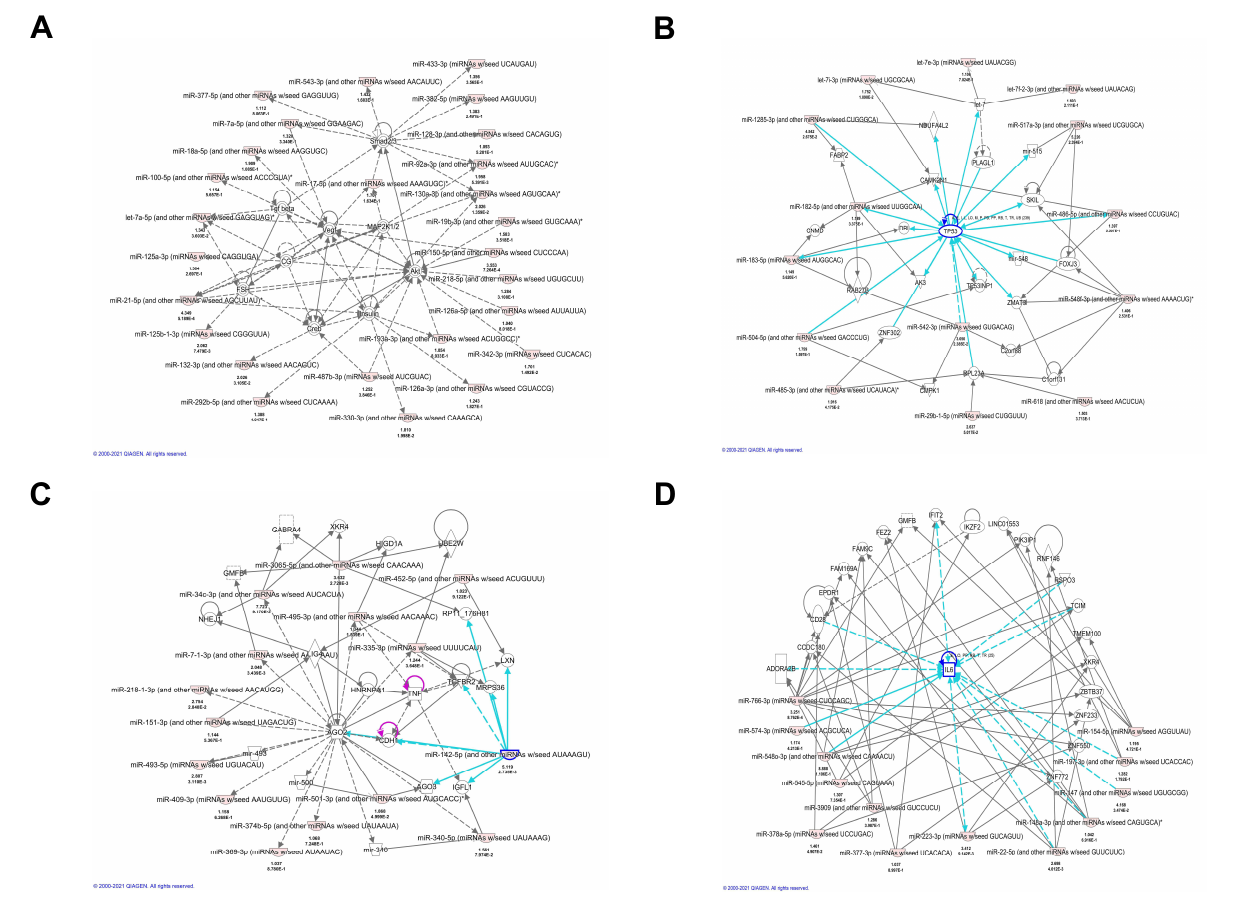
Figure 3. Top representative molecular networks involving differentially expressed miRNAs in LS identified by IPA analysis. ( A) Differentially expressed miRNAs that are involved in AKT gene regulation. ( B ) Differentially expressed miRNAs that are involved in TP53 regulation. ( C ) Top representative network involving miR-142-5p in cell–cell interaction, cell death, cell survival and cellular assembly and organization0. ( D ) A network involving IL-6 regulation related to inflammatory diseases, organismal injury and